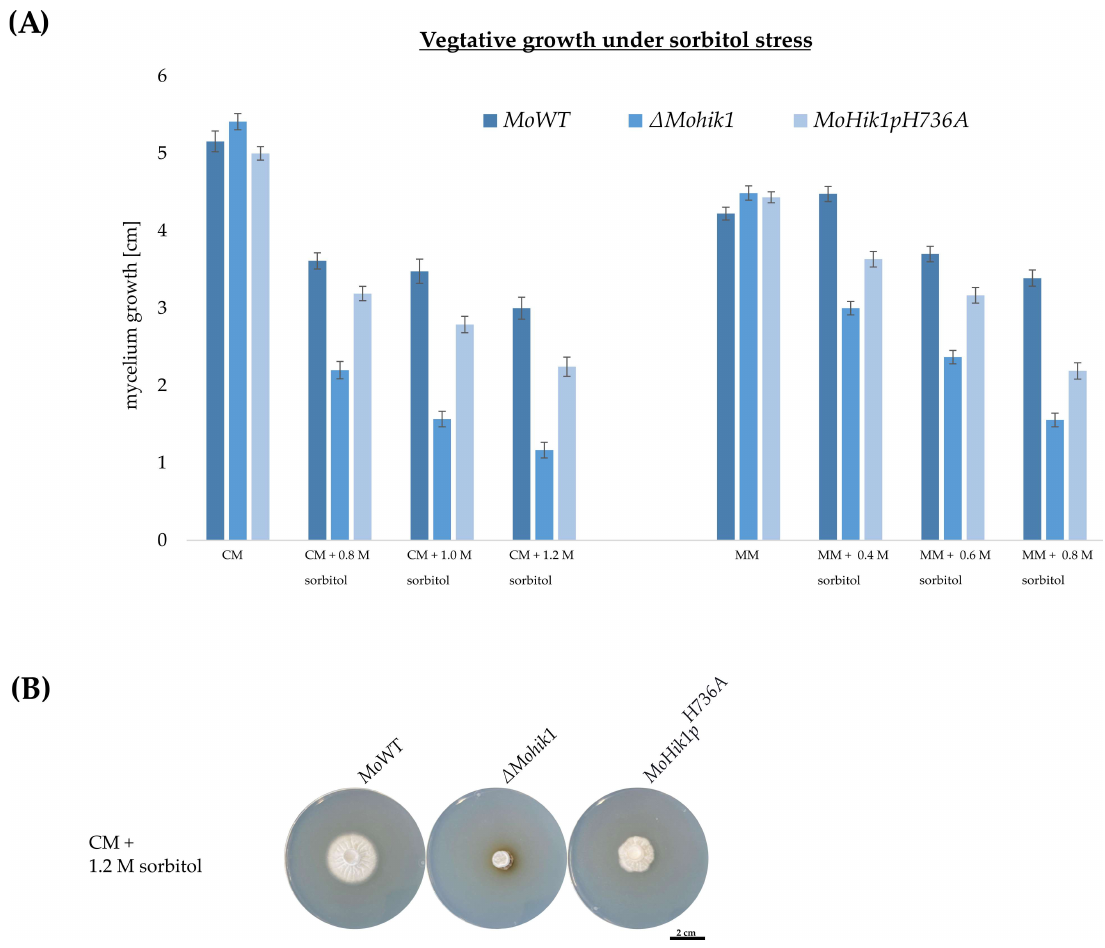
Figure 3. ( A ) Vegetative growth of MoWT , the loss-of-function mutant ∆ Mohik1 and the MoHik1p H736A mutant under osmotic stress. The growth was measured on complete media (CM) and minimal media (MM) supplemented with different concentrations of sorbitol. The incubation time was 7 days at 26 ◦ C. ( B ) Pictures of the cultures grown for 7 days on CM + 1.2 M